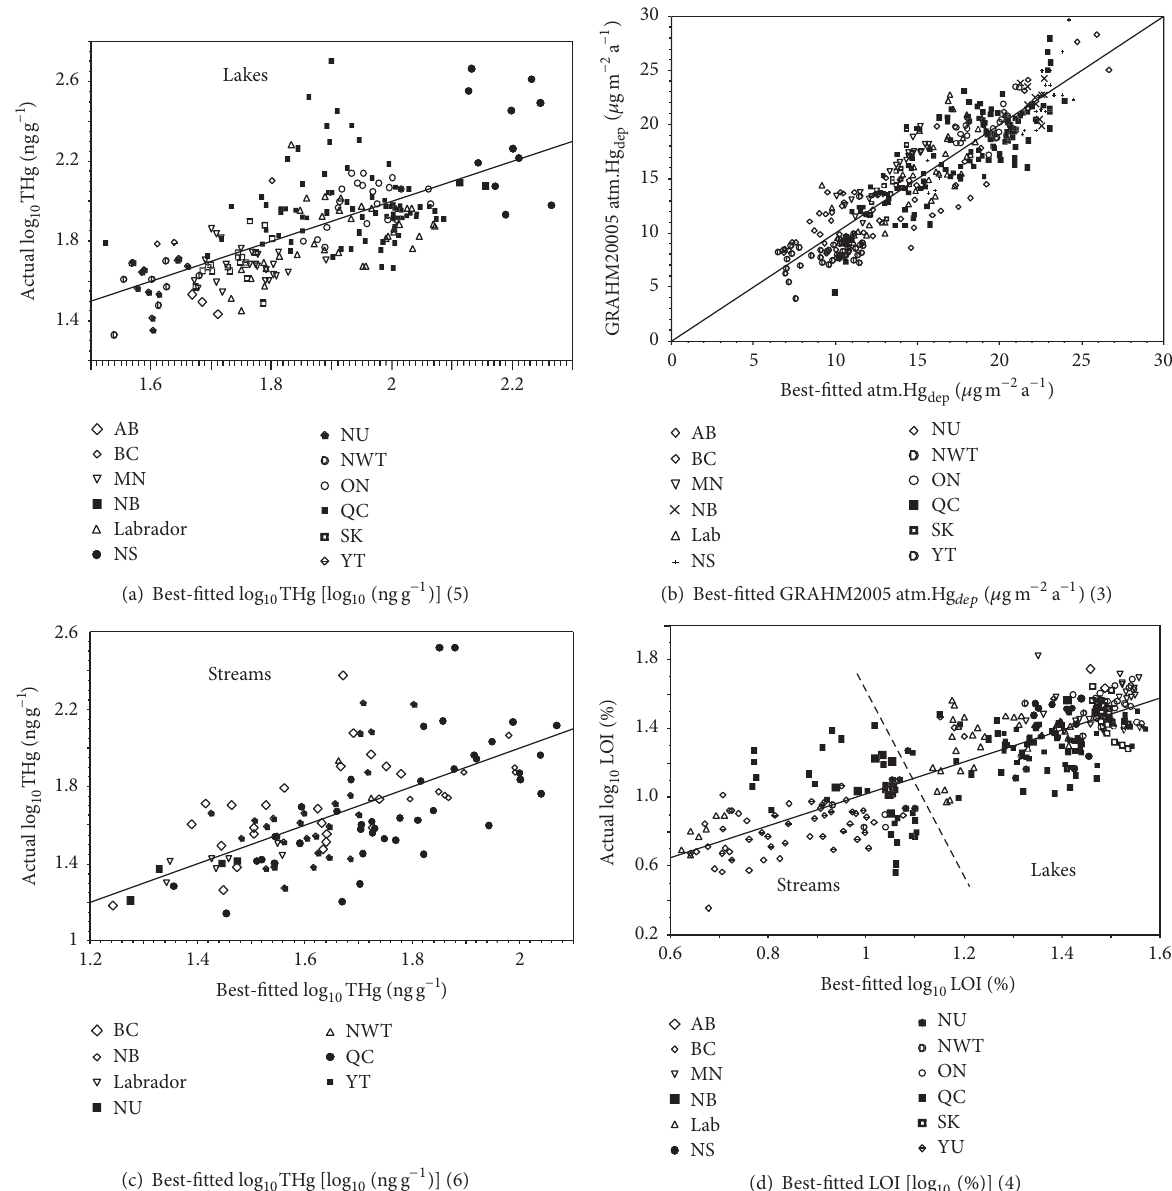
Figure 6: Scatterplots of actual versus least-squares best-fitted (i) lake (a) and (ii) stream (c) sediment log 10 THg [log 10 (ngg −1 )], (iii) GRAHM2005 atmospheric Hg deposition ((b); model), and (iv) stream and lake sediment log 10 LOI ((d); dashed line separates the lake from the stream dots); all symbolized by provinces/territories (Table